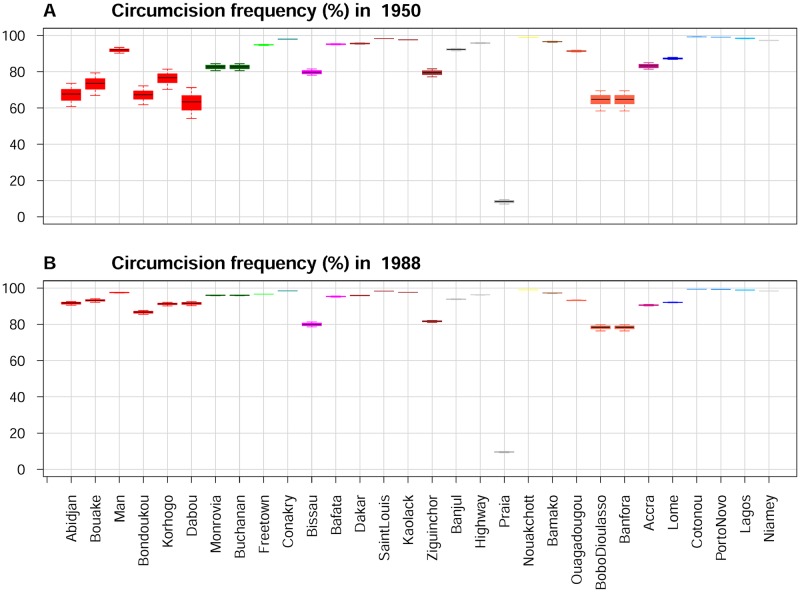
Estimated MC frequencies for the West African cities.Estimated MC frequencies in 1950 (A) and 1988 (B) for the West African cities. Boxes indicate the interquartile range (IQR) of the frequencies; median is indicated by a horizontal line within the box, and whiskers extend to the farthest values that are not more than 1.5 times the IQR away from the box. Cities of the same country appear with the same color. Country colors: Côte d'Ivoire, red; Liberia, dark green; Sierra Leone, green; Guinea, dark cyan; Guinea-Bissau, magenta; Senegal, brown; Gambia, gray; Cape Verde, dark gray; Mauritania, yellow; Mali, chocolate; Burkina Faso, tomato; Ghana, violet-red; Togo, blue; Benin, dodger blue; Nigeria, deep sky blue; Niger, light gray.